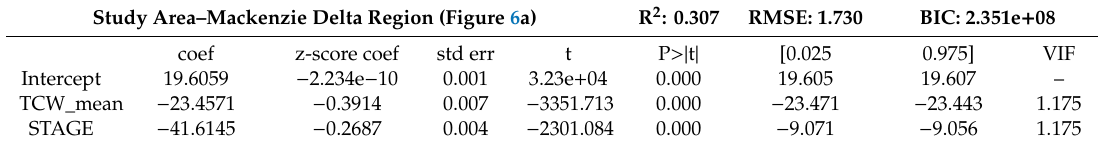
Table A3. Multiple linear regression output as obtained for the entire study area.